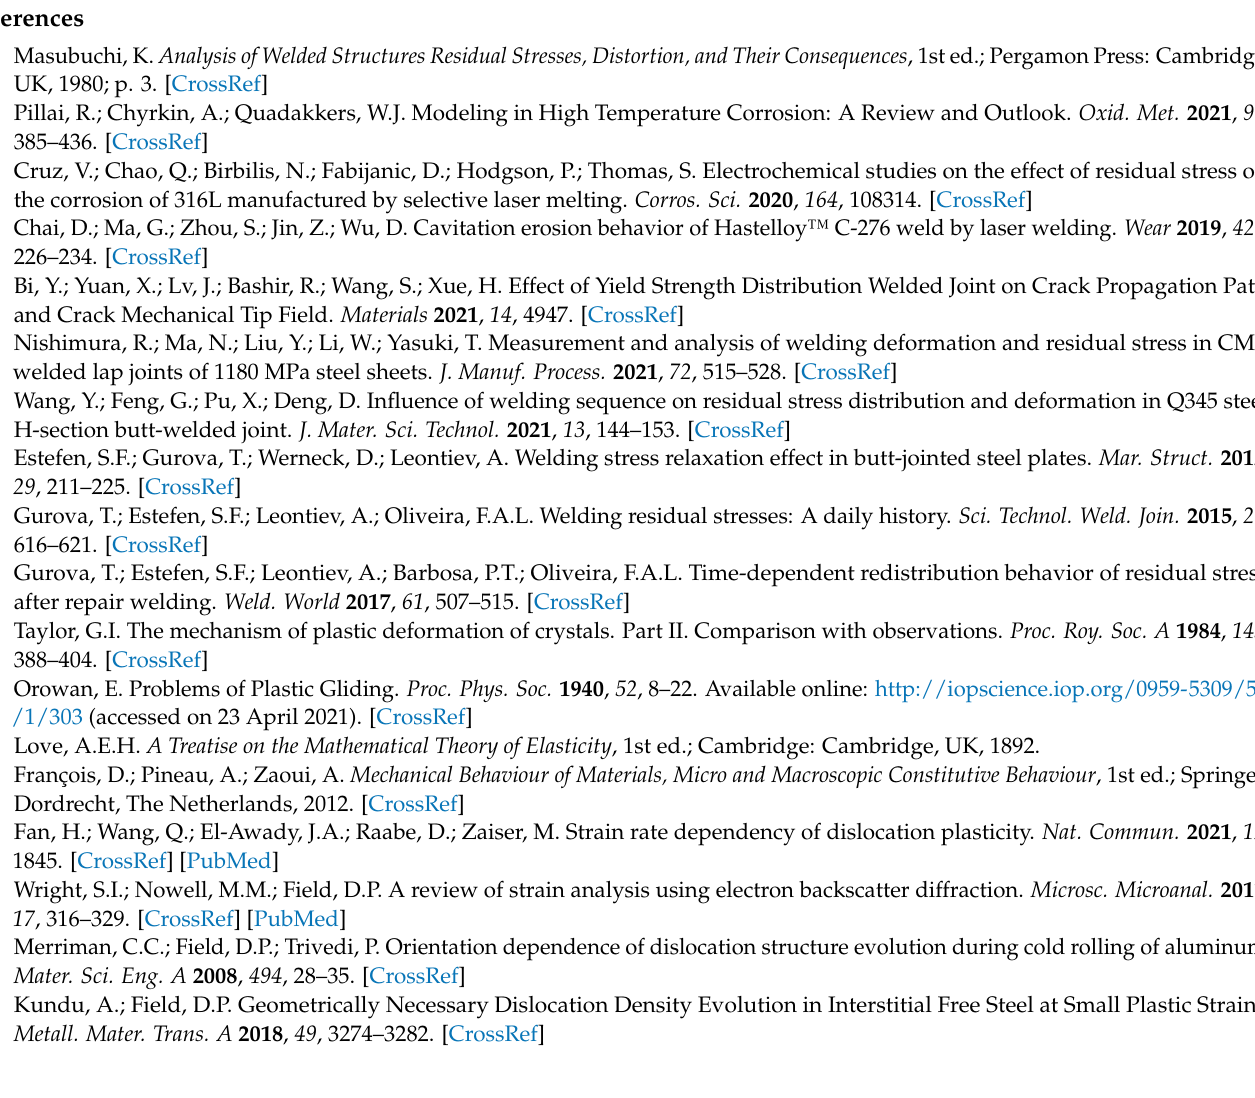
(d) The high-angle grain contours and the low-angle grain contours showed rearrange- ment due to a rearrangement of the dislocations over time; these changes were related to the change in residual stresses that, after two weeks,